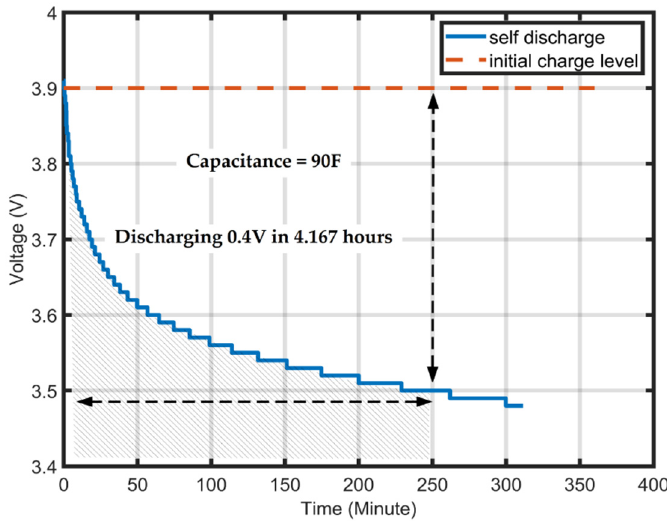
Figure 20. The measured supercapacitor voltage drops due to self-discharge impact (open-circuit). The voltage drop can be minimized by increasing the deep sleep duration. However, the WDT of the ATMEGA328P has a maximum time-out duration of 8 s. Table 3 shows the results of the proposed firmware-based power reduction technique. In this measurement, the transmission power of the LoRa module was set to a fixed gain of 7 dbm; also, the power consumption was measured with a fixed input voltage of 3.7 V. The results prove the efficiency of disabling the ADC, reducing the internal clock frequency to 1 MHz, and selecting the power-down sleep mode. This technique reduced power consumption during the sleep mode to 21.09 µ W and 11.1 mW in the operation mode. Figure 21 shows the current consumption during the initialization, operation, and sleep mode concerning the solar input the boost charger Table 3. Comparison of power consumption with different firmware configurations (at 3.7 V, Tx gain 7 dBm).